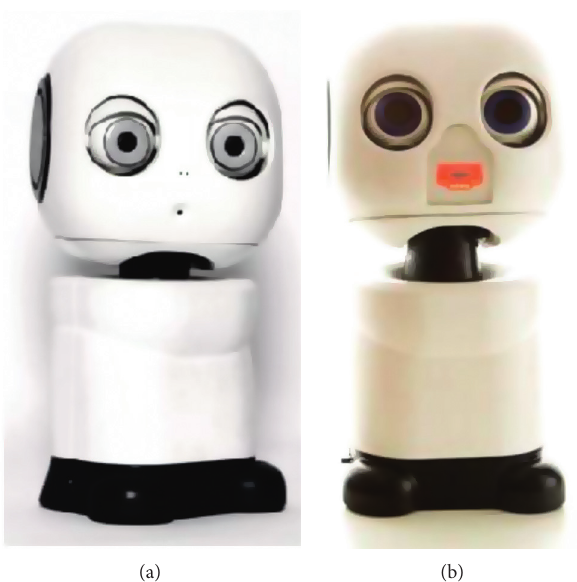
Figure 1: IVEY, the socially assistive robot used in this study. (a) A 3D printable robot available from Hello Robo, Inc. (b) IVEY with postproduction light-emitting diode (LED) mouth allowing simulated effect.